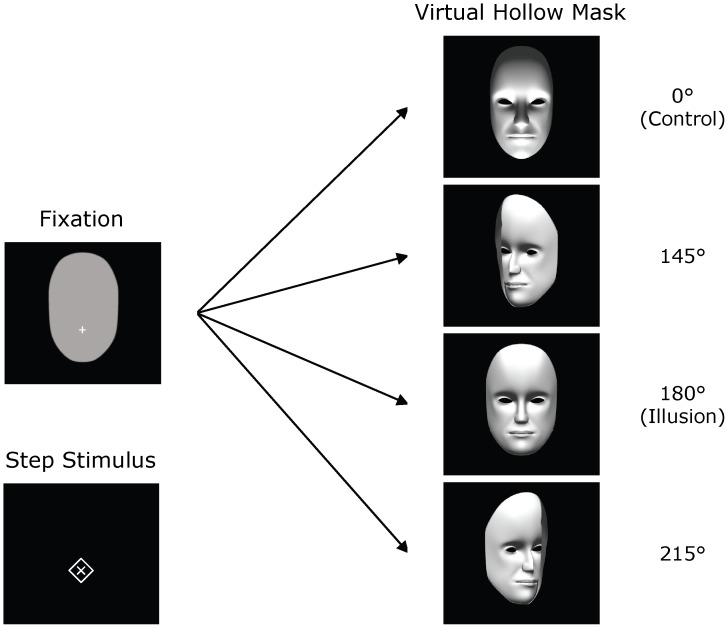
The fixation and virtual hollow-mask stimuli (presented without disparity information for illustration purposes).The 0° and 180° mask orientations correspond to the control and illusion conditions, respectively. The vergence step stimulus is also presented (see text for details).